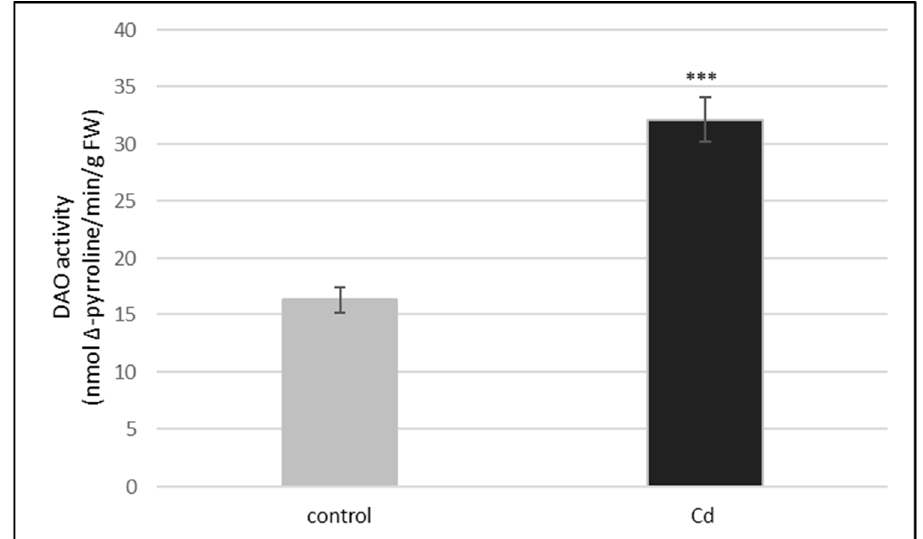
Figure 2. DAO activity in the roots of cucumber seedlings treated with 10 μ M Cd. DAO activity was measured in the control plants and plants, which after 3 days of treatment with Cd were transferred to the control conditions for another 3 days (Cd). The data are presented as means ± SD from three independent experiments with each experiment performed in six replicates. There was a significant difference between DAO activity in the control and Cd treated plants (asterisks indicate the significant differences, where *** p < 0.001). Table 1. Inhibition of DAO activity by AG. DAO activity was measured in the control plants (control, − AG) or in plants treated for 3 days with aminoguanidyne added to the nutrient solution before the collection (control, +AG) as well as in plants, which after 3 days of treatment with Cd were transferred to the control conditions without (Cd, − AG) or with aminoguanidyne (Cd, +AG) for another 3 days.